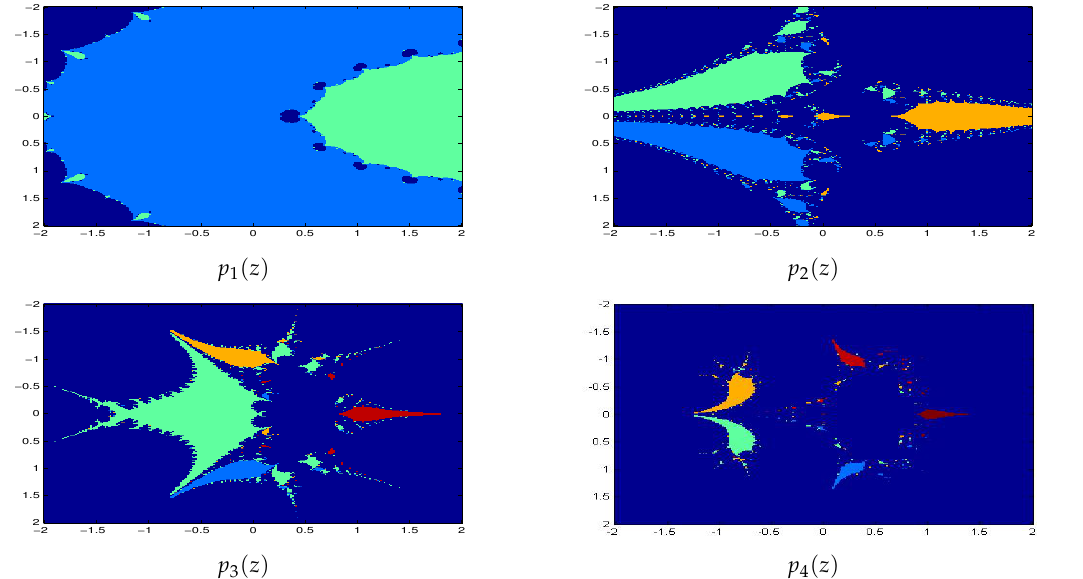
Figure 1. Basins of attraction for SM 2 for the